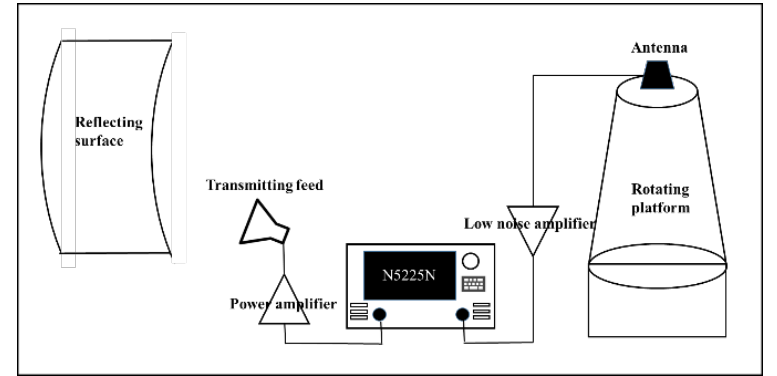
Figure 9. Diagram of microwave anechoic chamber detection